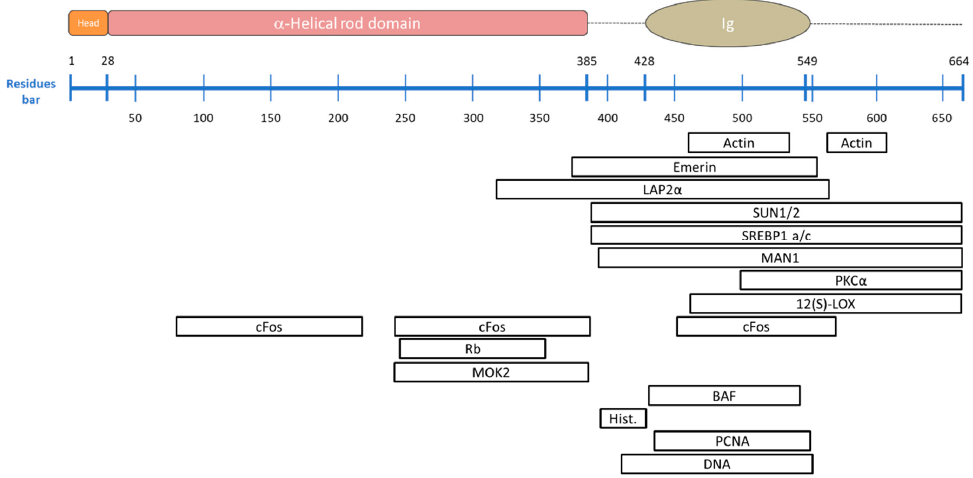
Figure 4. A-type lamin-binding partners at the nuclear envelope (NE) level. Lamina underlines the nuclear membrane and consists of A-type lamins (in blue) and B-type lamins (in red). Proteins interacting with A-and B-types lamins are schematized and their localization into the cell nucleus. The proteins interacting with lamins at the level of the nuclear envelope are thought to have mainly a mechanical and structural role; proteins bridging directly lamins and chromatin play a key role in reinforcing the nucleoskeleton and in mechanical regulation of gene transcription; others regulate cell signaling. Cells 2020 , 9 , x